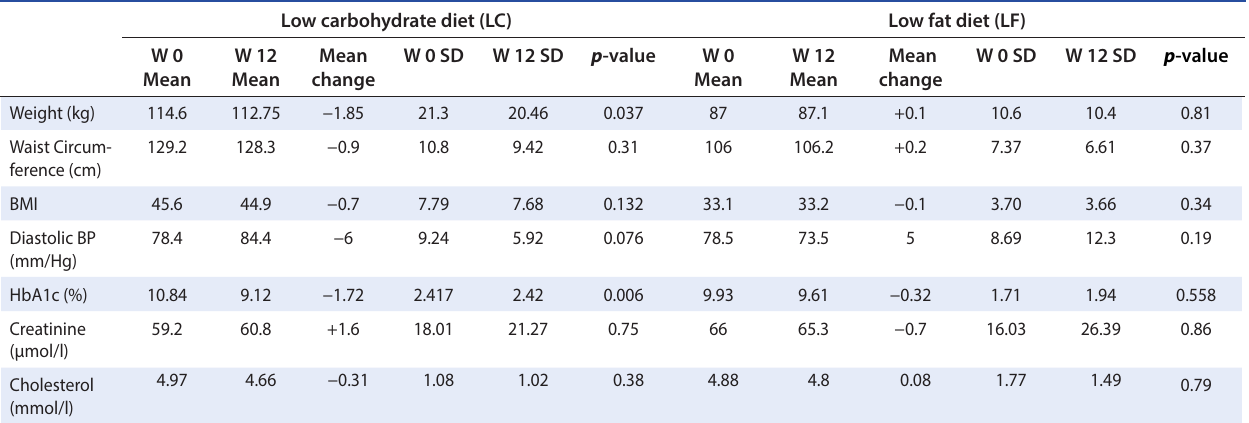
Table 1: Comparison of indicators for the diets at baseline (week 0) and after 12 weeks Low carbohydrate diet